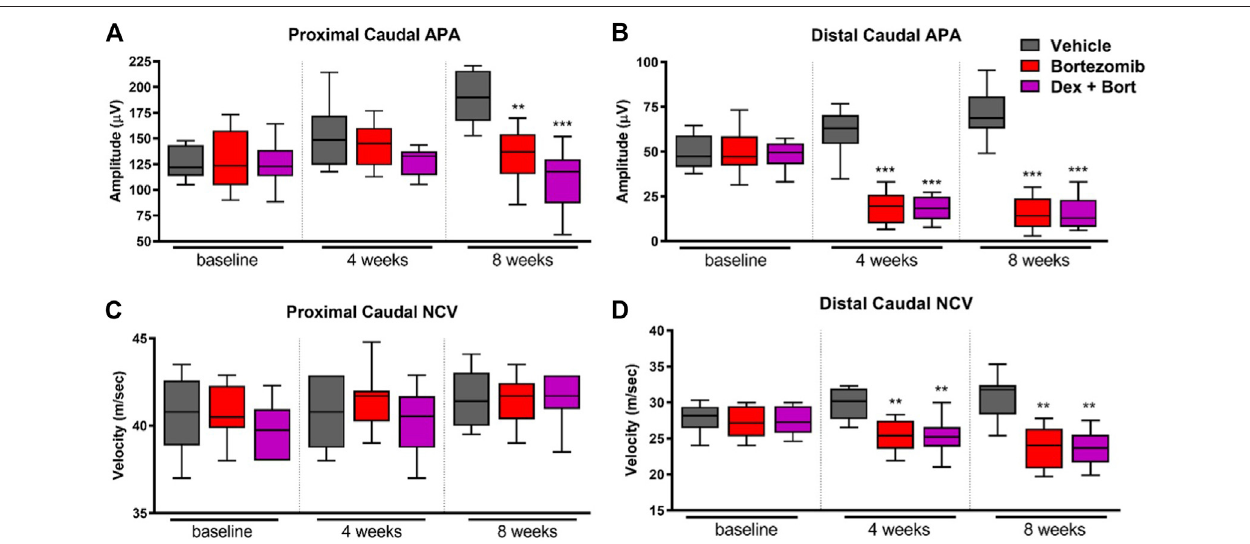
FIGURE 4 | Nerve conduction studies of bortezomib and dexanabinol treatment in rats. Neurophysiological values were determined at baseline, 4 weeks of treatment, and 8 weeks of treatment. Top panels show neurophysiological changes in (A) proximal caudal SAP amplitude and (B) distal caudal SAP amplitude. Bottom panels show neurophysiological changes in (C) proximal caudal sensory NCV and (D) distal caudal sensory NCV. Bortezomib (Bort) was administered IV (0.2 mg/kg) three times a week, and dexanabinol (Dex) was administered IP (10 mg/kg) three times a week approximately 30 min prior to bortezomib. GraphPad prism v7.04 was used to perform a Kruskal-Wallis test with Dunn ’ s correction for multiple comparisons across all groups. Only signi fi cant comparisons to vehicle (Vehicle) are displayed. p values are reported as: * ( < 0.05), ** ( < 0.01), *** ( <